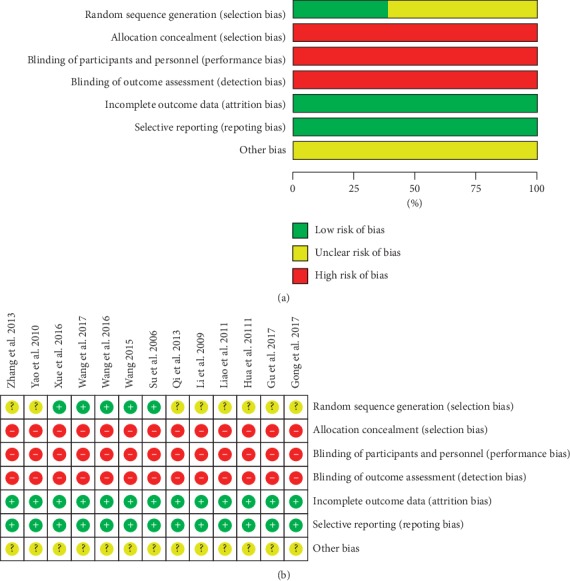
Methodological quality. (a) Risk of bias summary and (b) risk of bias graph.